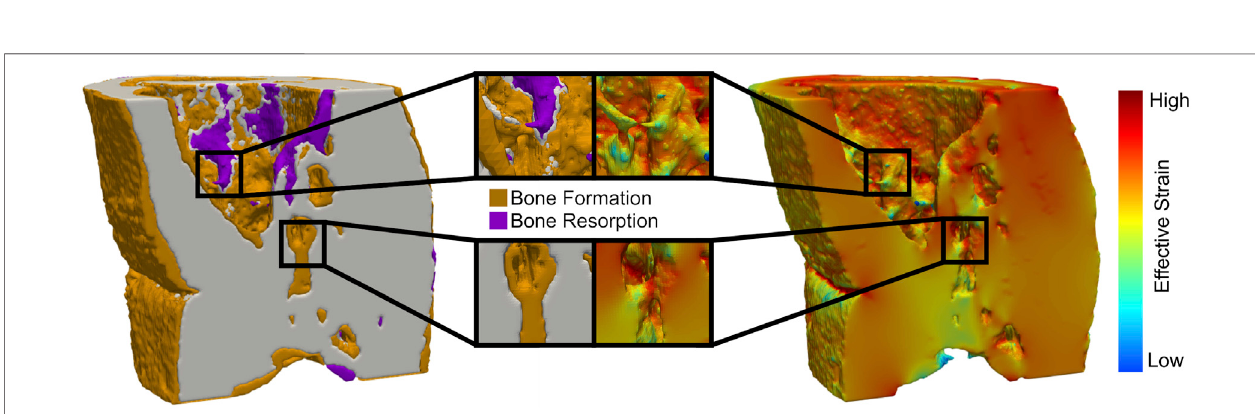
FIGURE 2 | Regions of high effective strain have a greater probability of new bone formation, while regions of low effective strain lead to bone being resorbed in all femur defect regions.